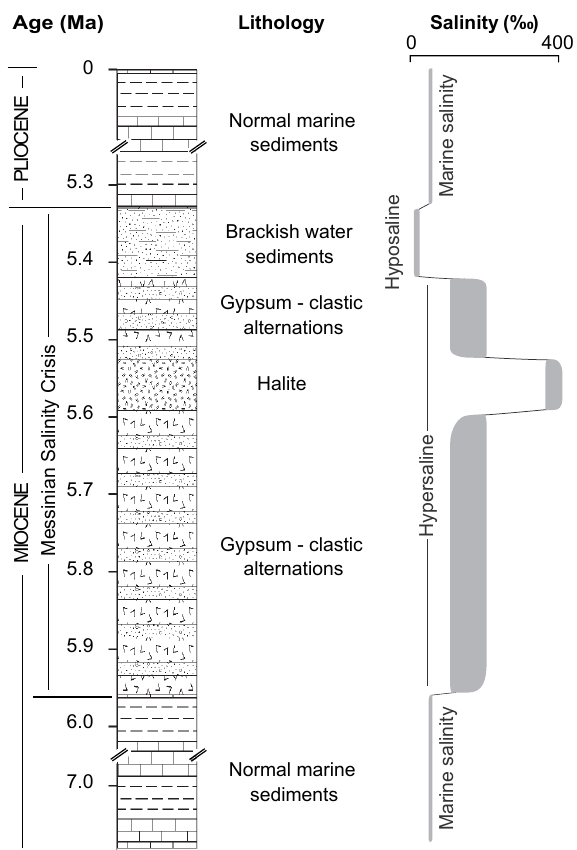
Fig. 1. Schematic composite section of the main Mediter- ranean lithologies over the Messinian Salinity Crisis, including the corresponding salinities in which the successions were de- posited/precipitated (after Ivanovic et al., 2013a). Timing of event boundaries are after Roveri et al. (2008) and references